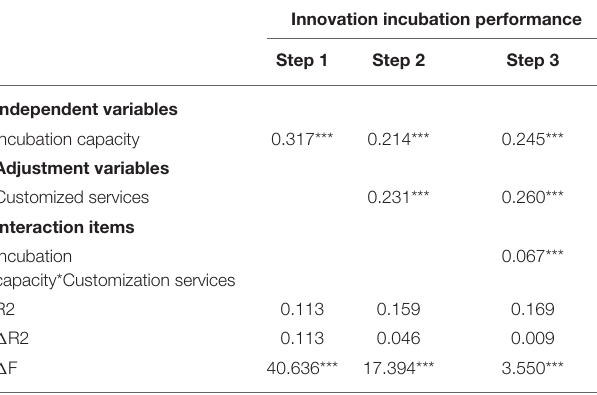
TABLE 5 | Moderating effect of customization